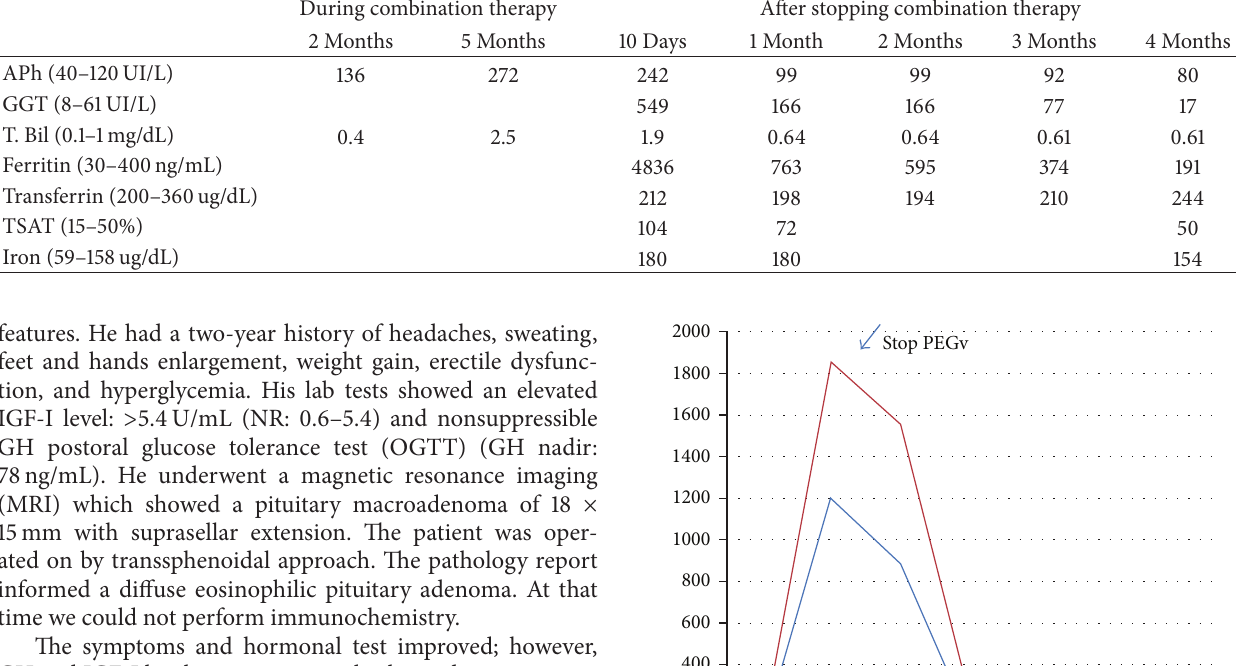
Table 1: Chronological development and values of alkaline phosphatase (APh), 𝛾 -glutamyltranspeptidase (GGT), total bilirubin (T. Bil), ferritin, transferrin saturation (TSAT), and iron during the combination therapy with PEGv and after stopping this treatment. During combination therapy